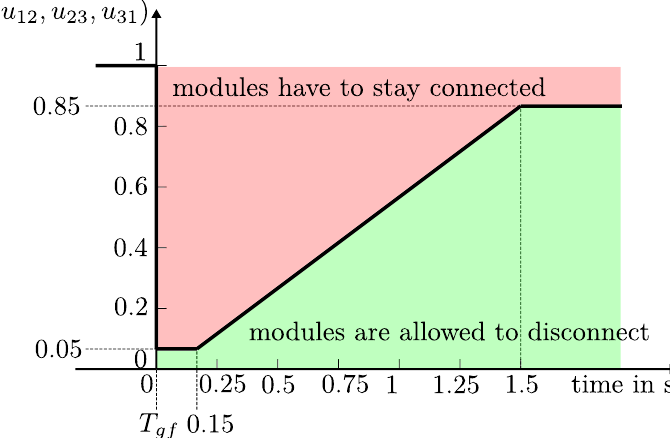
Figure 1. LVRT-curve for Type B non-synchronous power-generating modules (power park modules) in Austria [3]. The minimum phase-to-phase voltage at the PCCR is relevant to the decision of whether a module is allowed to disconnect or not. The LVRT-curve is valid both for symmetrical as well as asymmetrical grid faults. The starting point of the LVRT-curve is defined as T gf , which is described in Equation